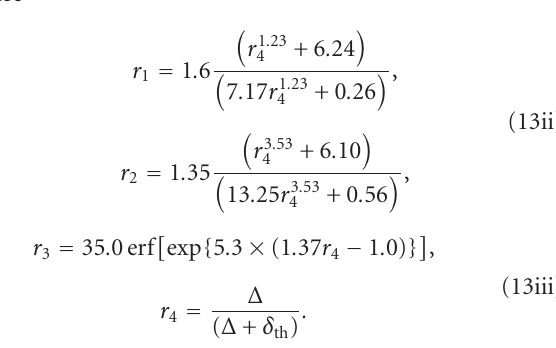
The predictions of (12) ensemble averaged on (cid:3) c isosurfaces are compared with the ensemble averaged values of C sg2 in Figure 5 all for cases for Δ = 0 . 8 δ th and Δ = 2 . 4 δ th , which show that (12) satisfactorily predicts the statistical behaviour of C sg2 when n = 1 . 0 and (13i), (13ii), and (13iii) are used for β 5